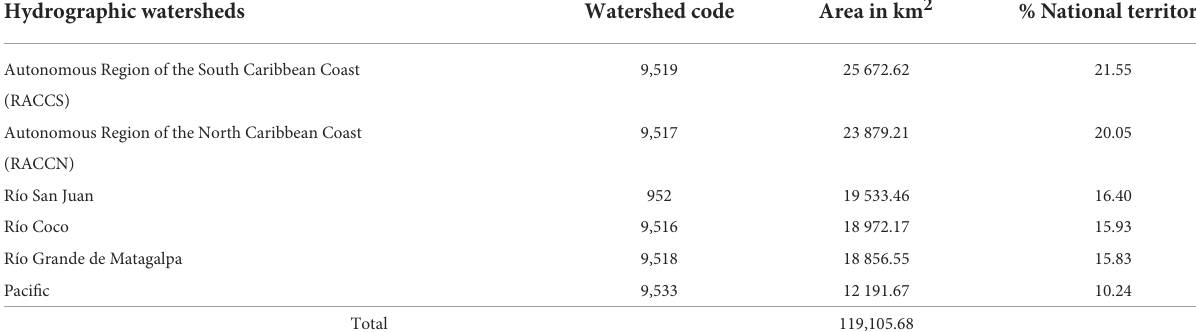
TABLE 4 Hydrographic watersheds of Nicaragua (prepared from Autoridad Nacional de Agua (ANA), Instituto Nicaragüense de Estudios Territoriales (INETER), Deutsche Gesellschaft für Internationale Zusammenarbeit (GIZ), Programa de Asistencia Técnica en Agua y Saneamiento (PROATAS) y Universidad Nacional de Ingeniería (UNI), 2014), area and percentage of